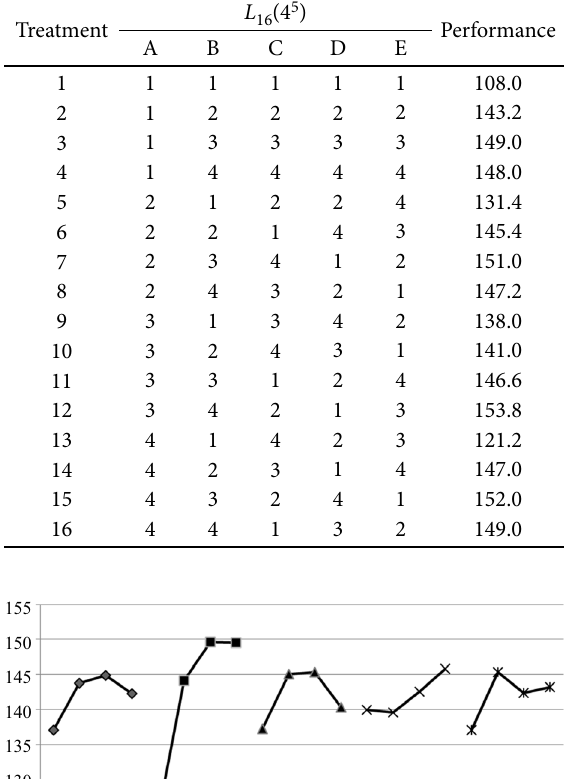
Table 2. L 16 (4 5 ) orthogonal array and experimental results